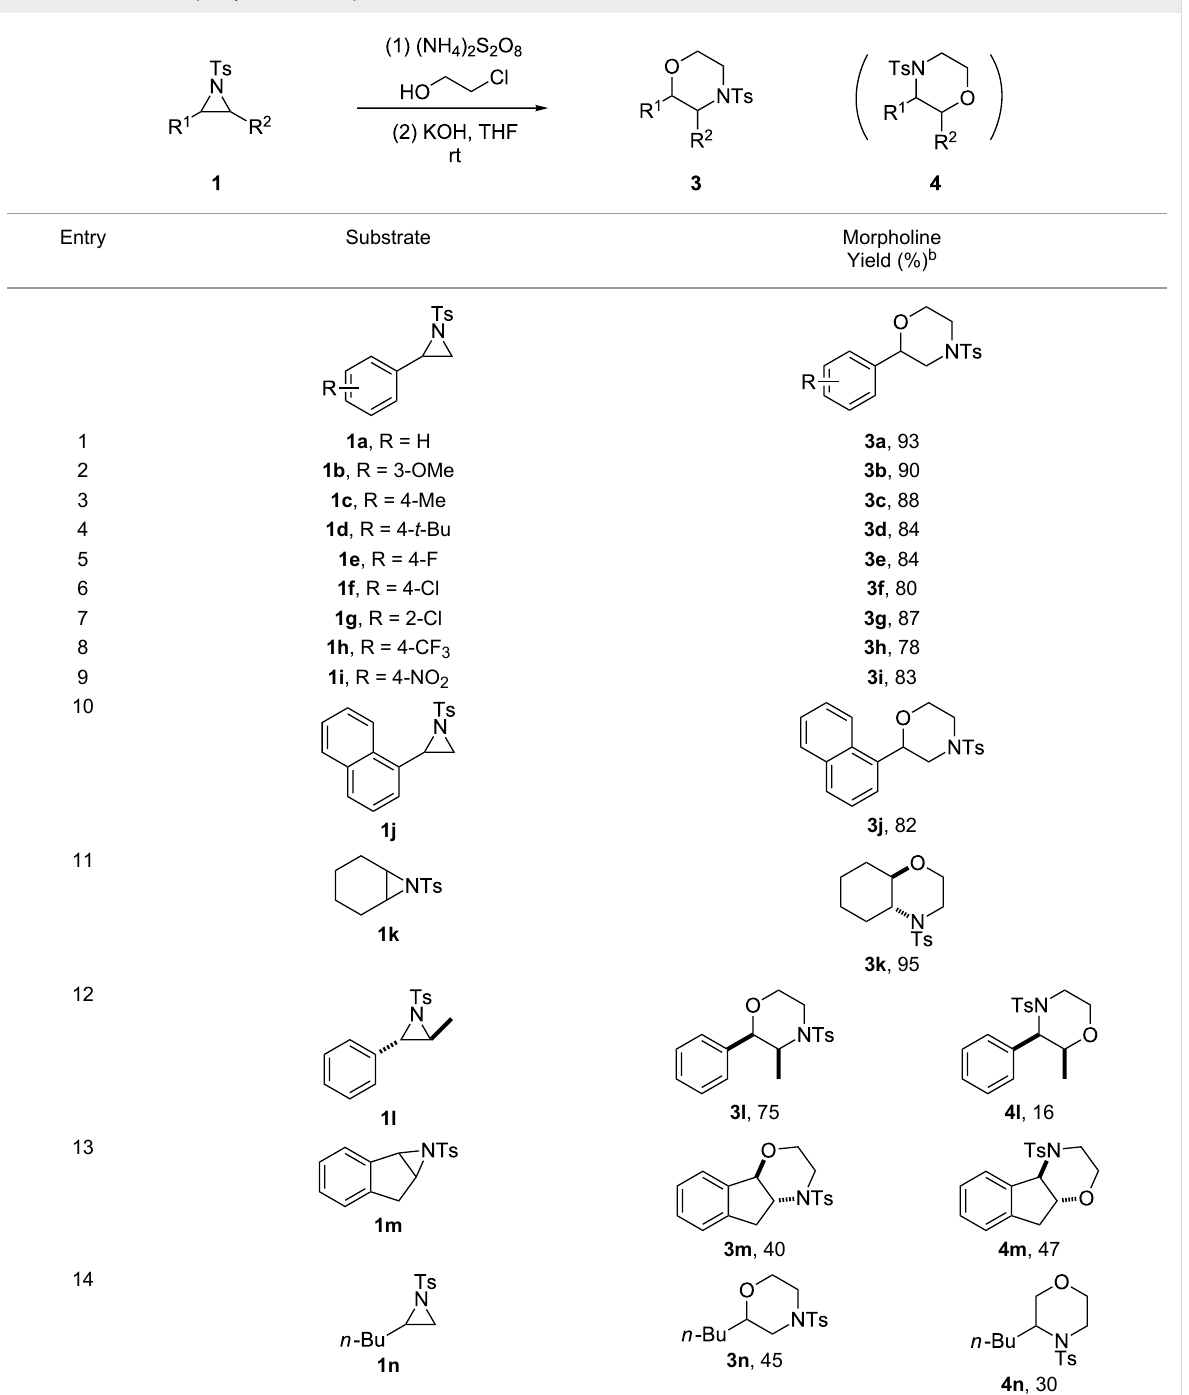
Table 2: Metal-free one-pot synthesis of morpholines from aziridines. a